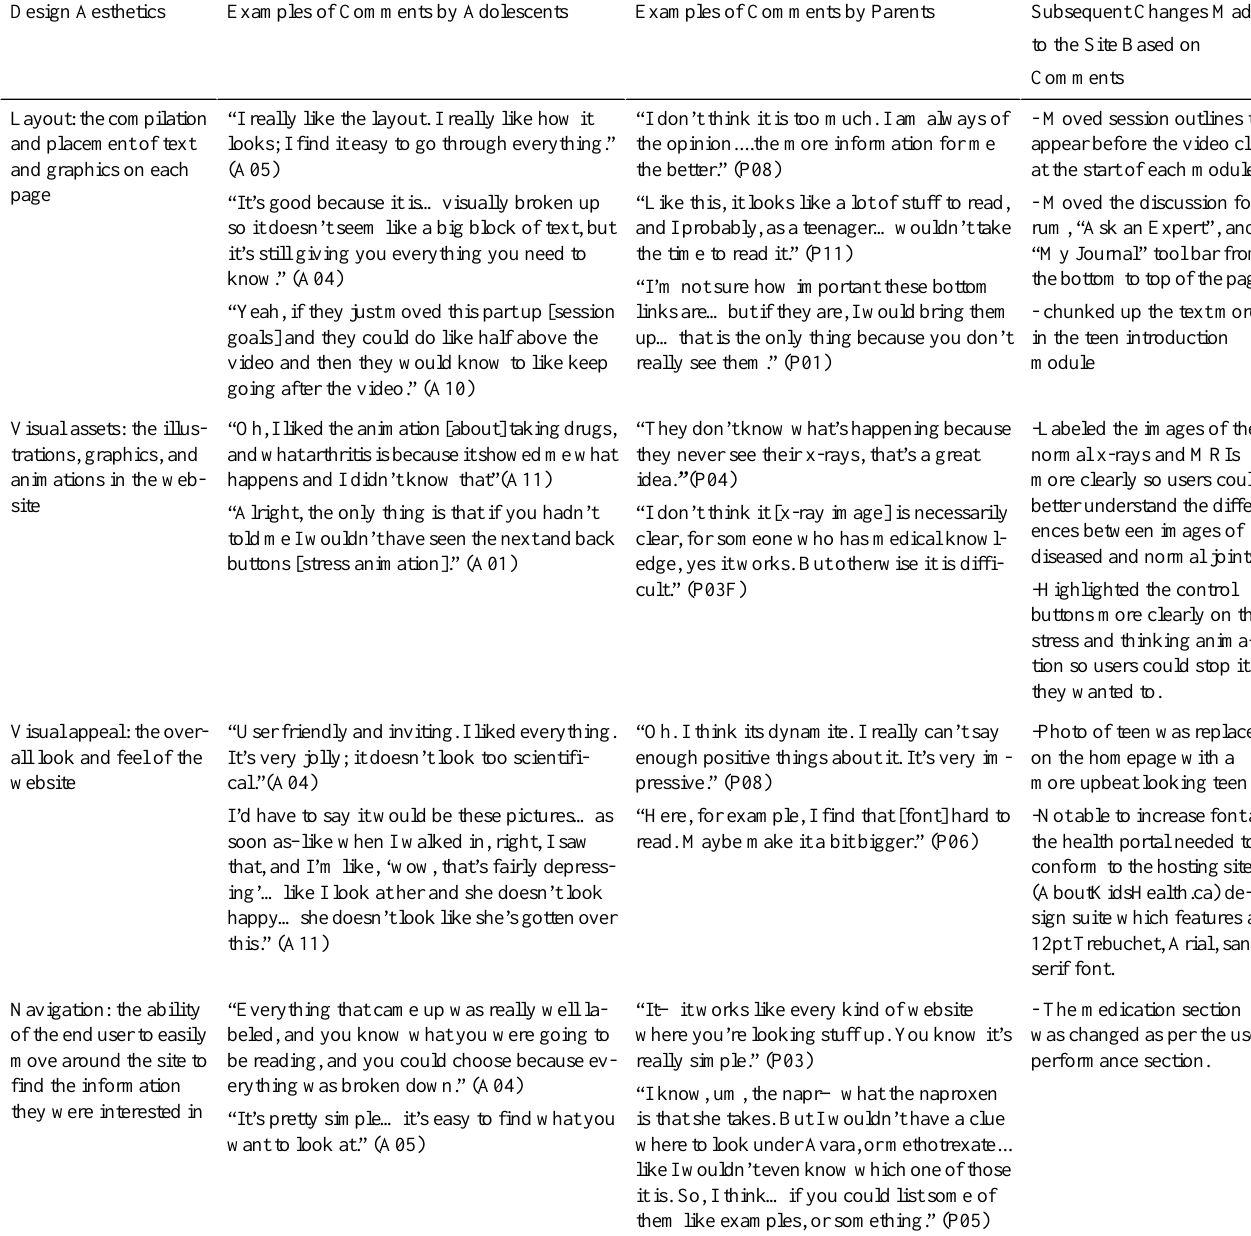
Table 3. Summary of user satisfaction with design aesthetics and changes made to the site